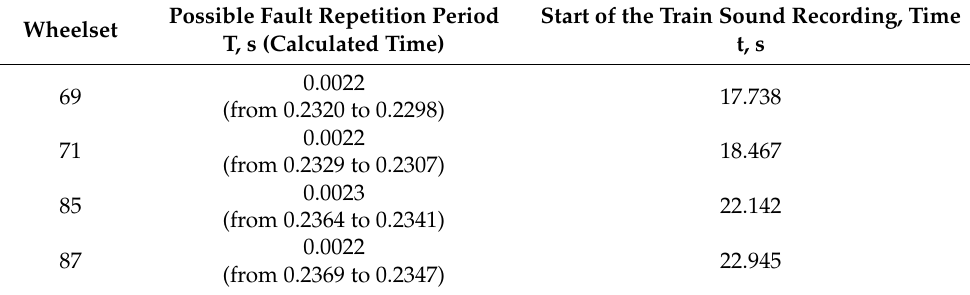
Table 5. Recording time of possible